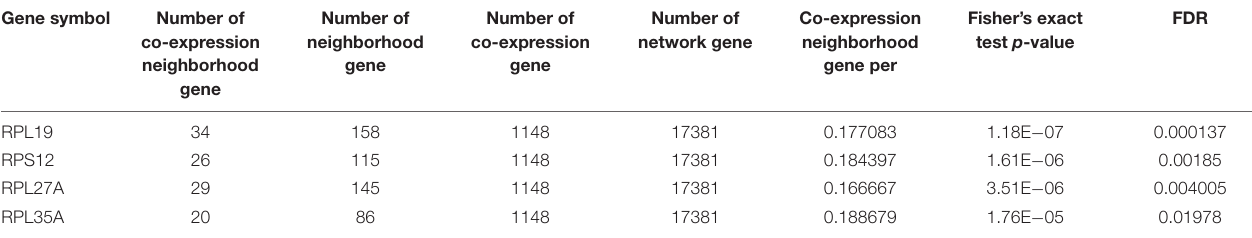
TABLE 2 | Screened cancer-specific genes. Gene symbol Number of